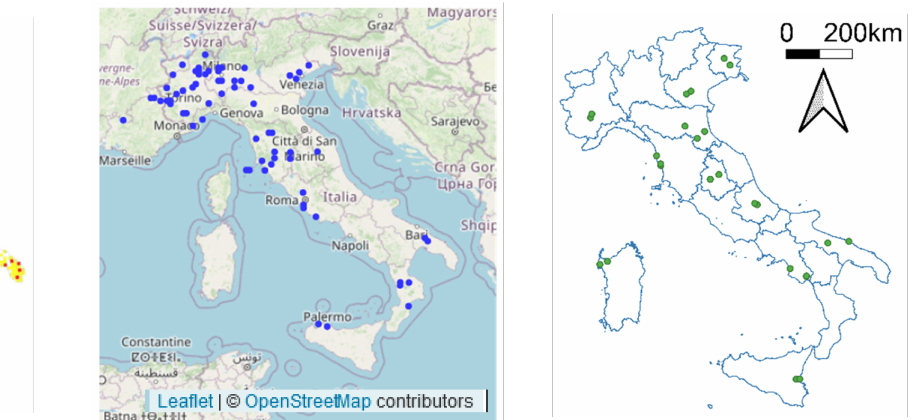
Table 2. Past and ongoing monitoring in Italy; distribution maps obtained from different sources as reported.